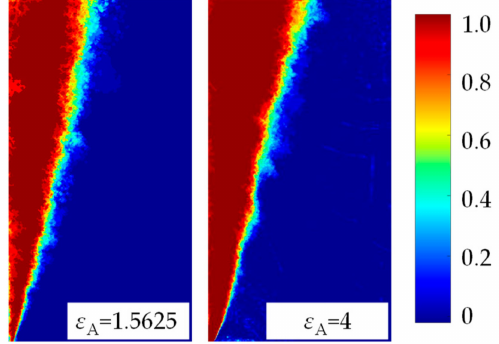
Figure 12. Overlaid steady state results.